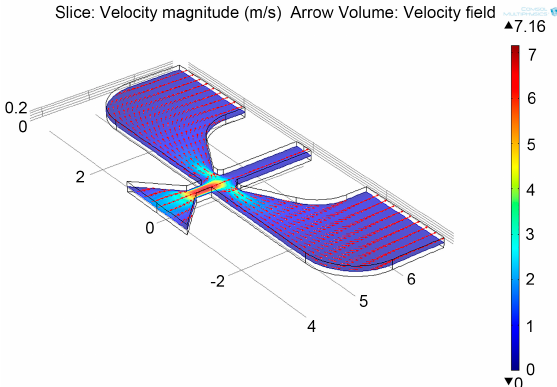
Figure 4. Velocity field distribution of the virtual impactor.